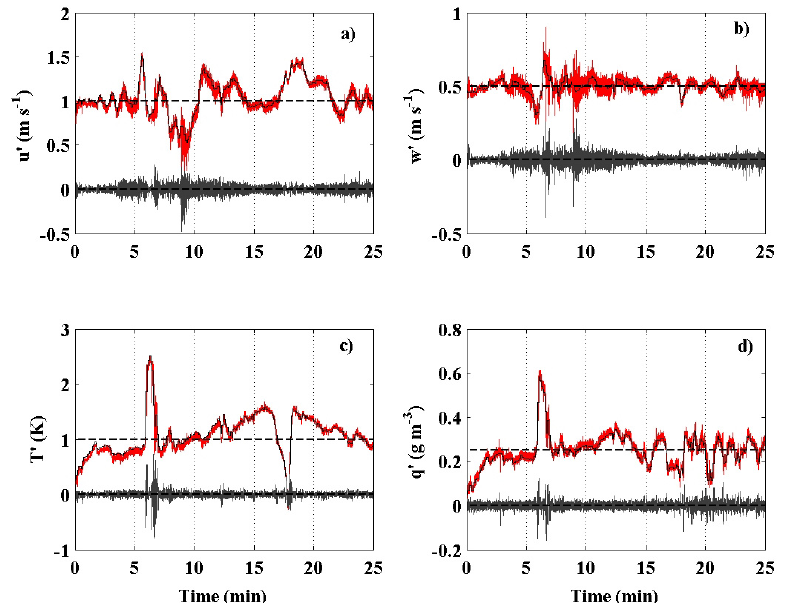
Figure 9. As per Figure 8, but for the case of the “dirty” wave shown in Figure 3 (Wave 2). The threshold frequency used to separate the wavy and turbulent components ( f ~0.1 Hz) was chosen on the basis of the spectral analyses shown in Figures 6 and 7.